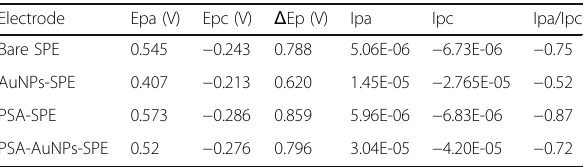
Table 2 Electrochemical data acquired from the CVs of carbon SPE before and after modification with PSA latex particles and